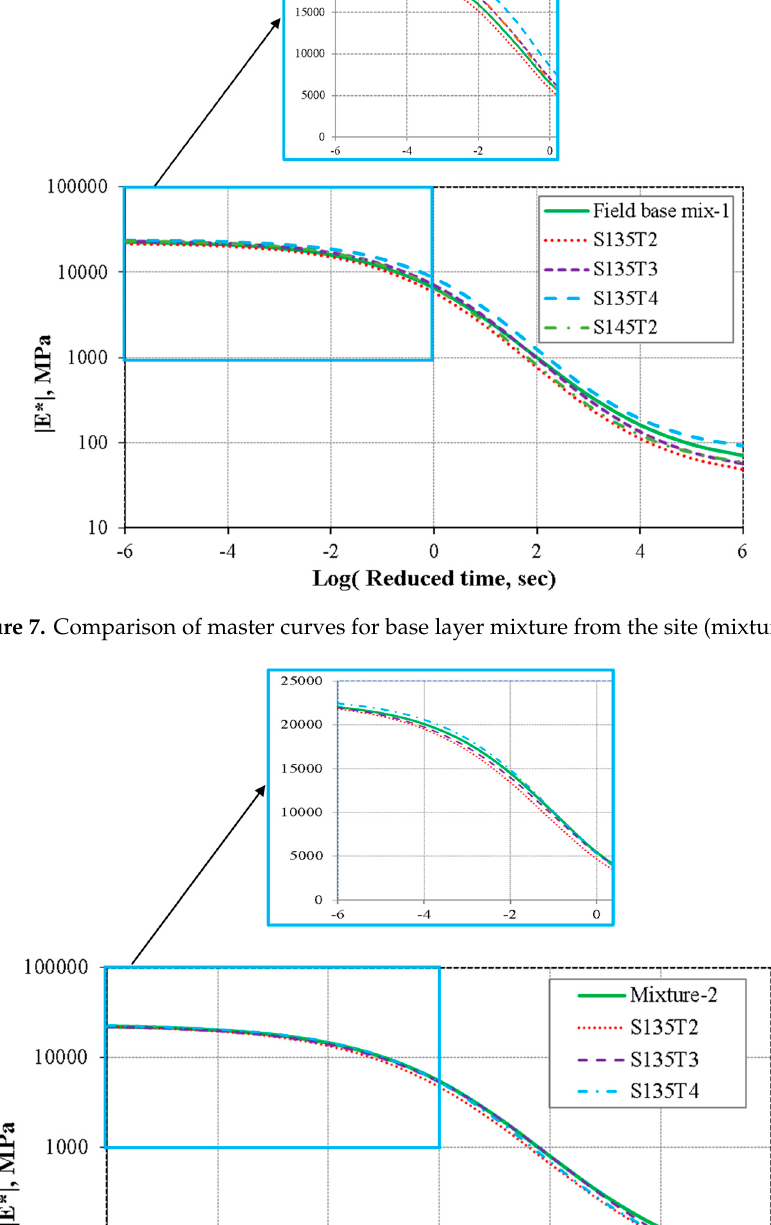
Table 5. Comparison of dynamic modulus results on mixture 3.